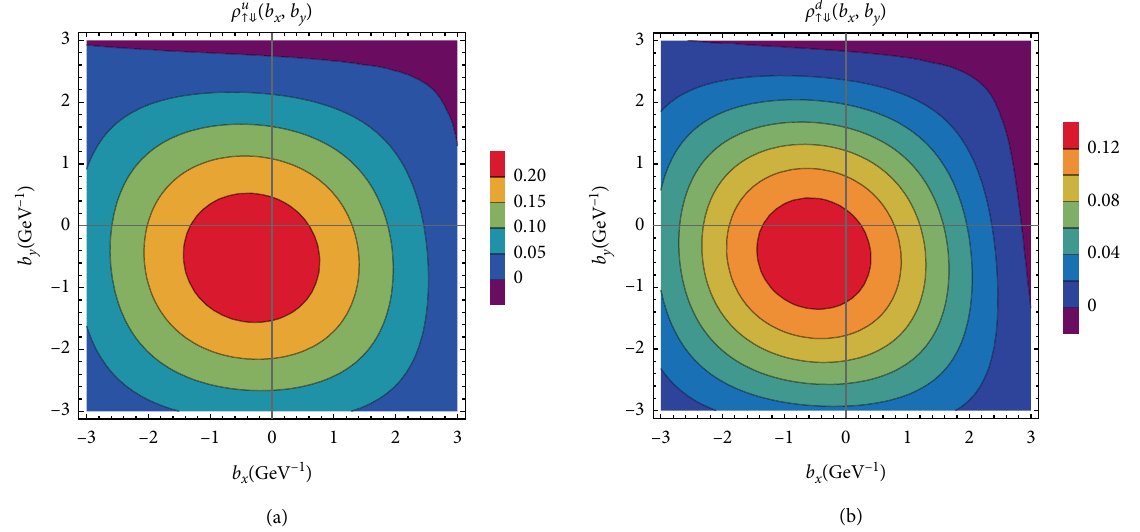
Figure 5: The plot of Wigner distribution 휌 (left panel) and 𝑑 -quark (right